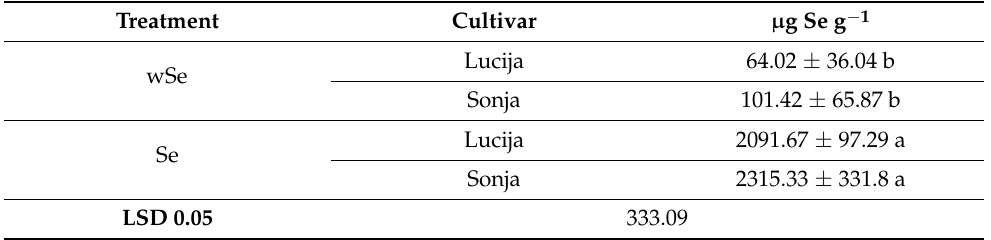
Table 1. Mean values ± standard deviations of Se contents in soybean grains after foliar biofortification